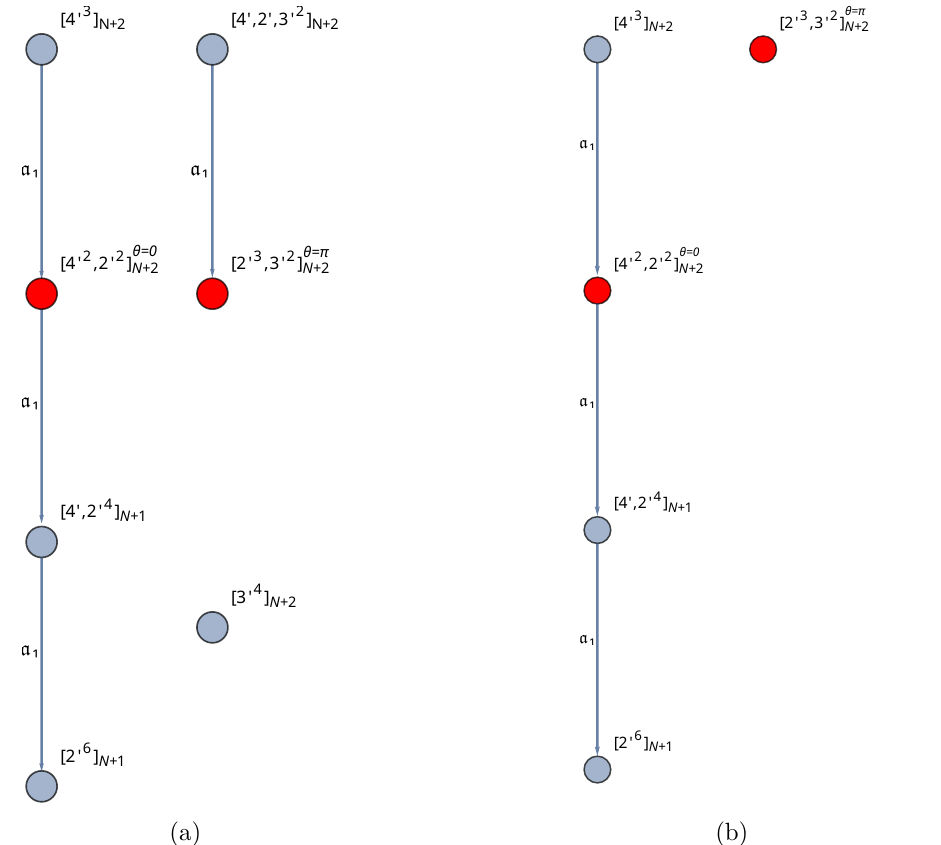
Figure 11. (a) Hierarchy for massive E 2 -theories with n 0 = 7 and k = 19 ; (b) hierarchy for massive E 1 -theories with n 0 = 8 and k = 20 . Notice the presence of an isolated theory in both cases.